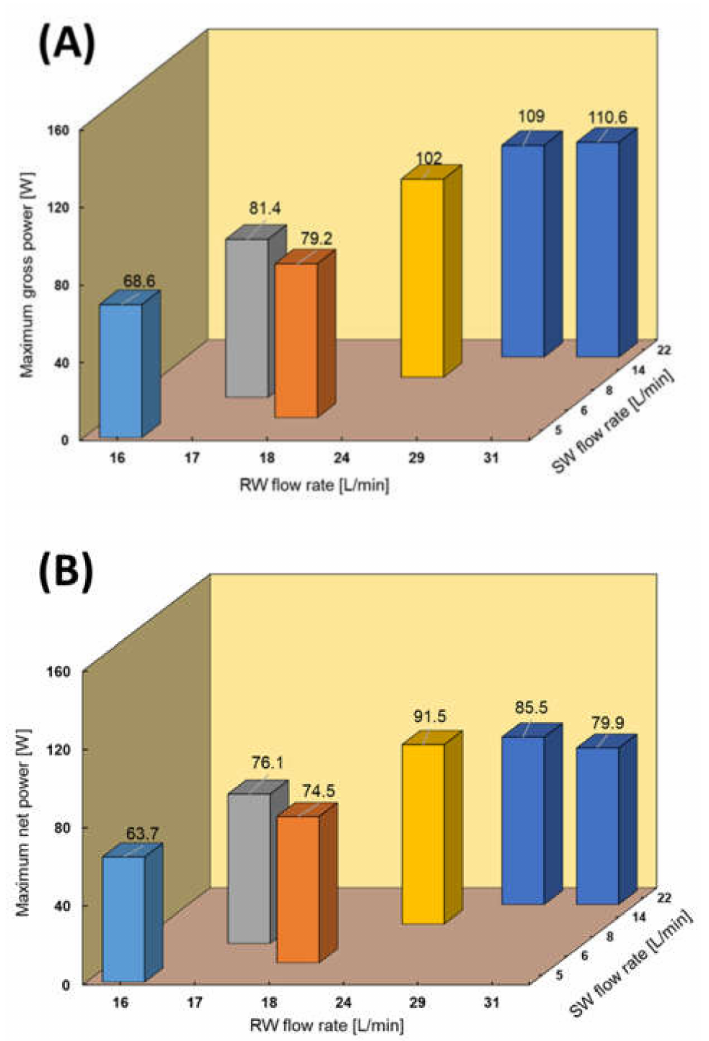
Figure 9. RED stack performance using natural SW/RW feed solutions. ( A ) Maximum gross power density against feed flow rate, ( B ) Maximum net power against feed flow